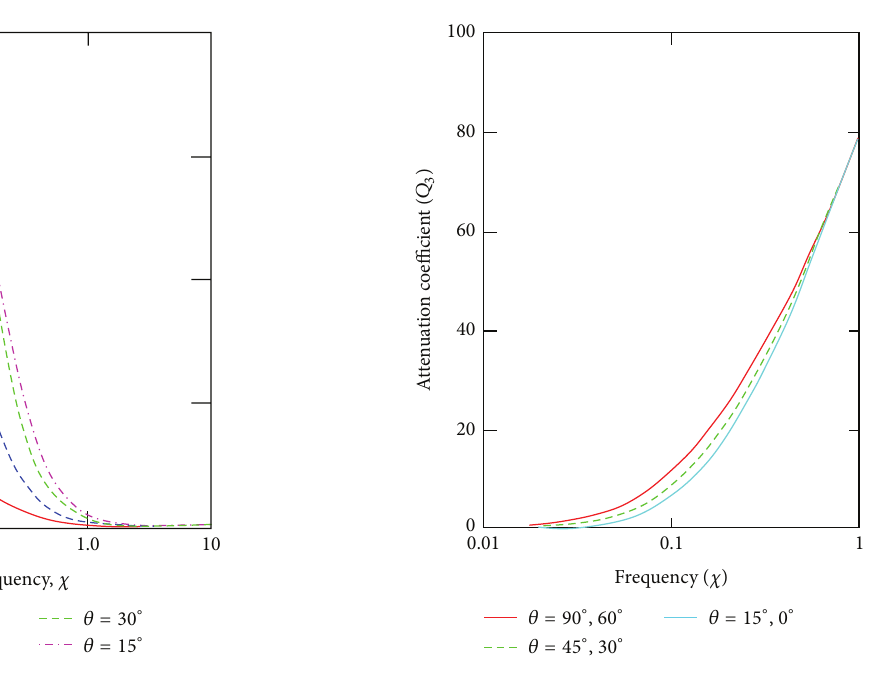
Figure 4: Variation of QT attenuation coefficient with nondimen- sional frequency in various direction of propagation.